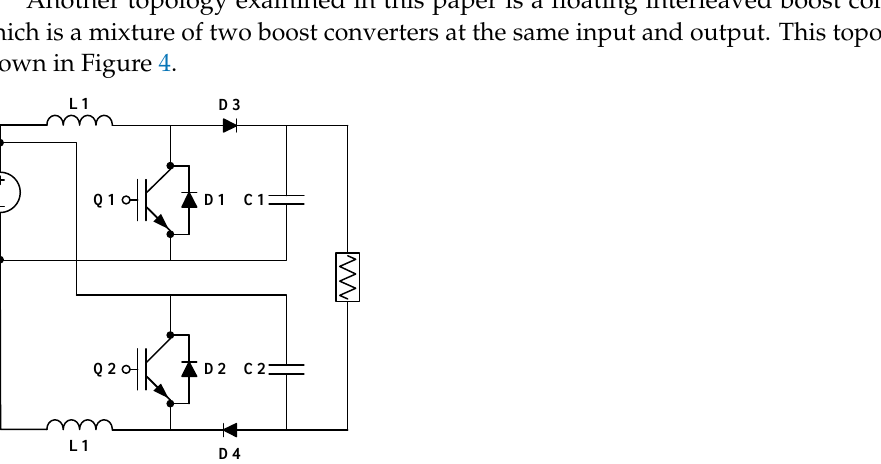
Figure 4. Circuit diagram of the floating interleaved boost converter.